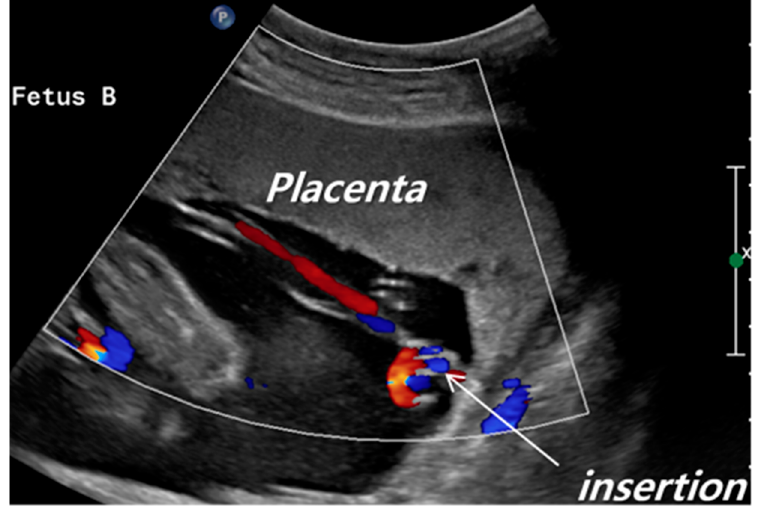
Figure 1. Velamentous cord insertion demonstrated with color Doppler imaging in the mid-trimester.